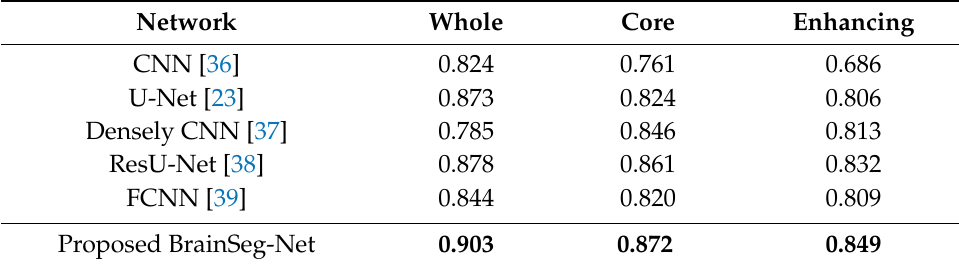
Table 2. Results comparison on the BraTS 2017 HGG data.